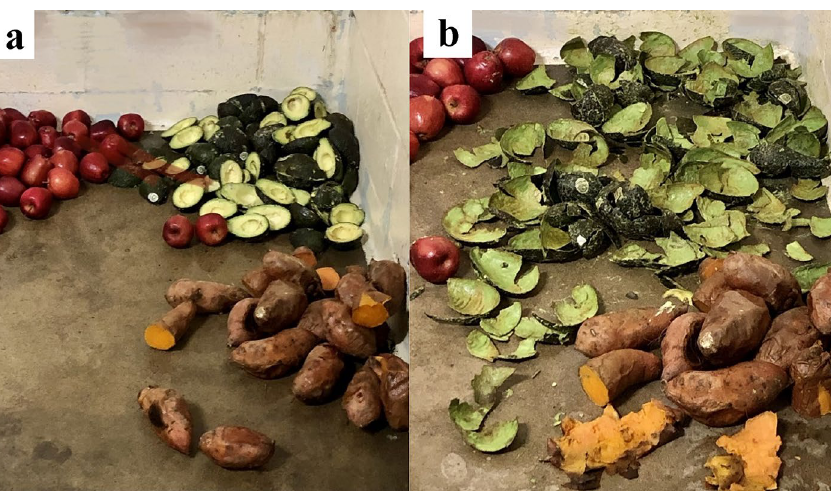
Figure 2. Foods offered to an adult sloth bear ( a ) and the residue left at the end of a meal ( b ). Note the clear focus on avocado flesh and minimal consumption of baked yams. No apples were consumed by any bear during the 10-day study. The whey feeder was attached elsewhere in the pen and is not shown (Photos c/o Travis